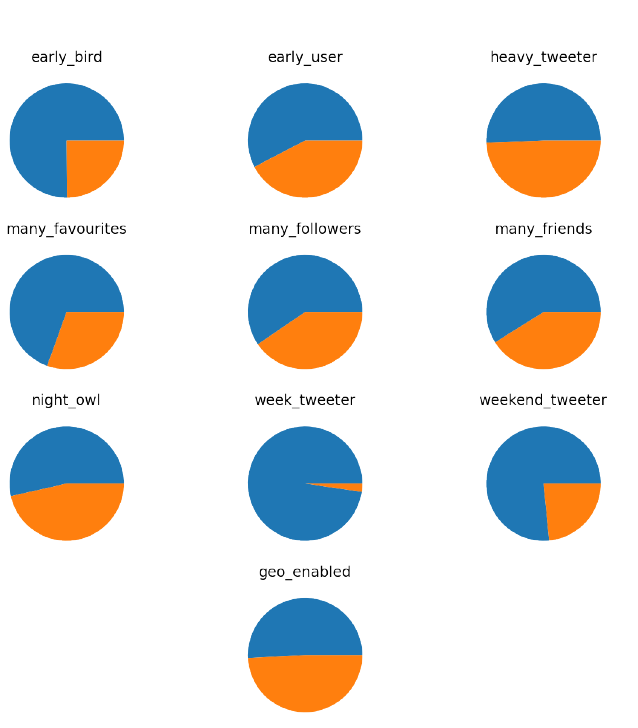
Figure 4. All user feature distribution.